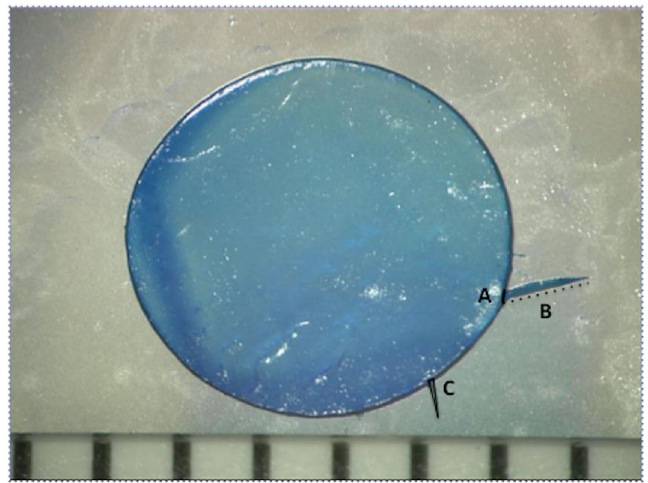
Figure 5. Description of an arc-length, tag-length and tag-area of a capsular tag. ( A ) The arc-length is the distance between the two edges of a capsular-tag, which are attached to the capsule (black line). ( B ) The tag- length is the distance between the edge of a capsular-tag attached to the capsule and the farthest unattached edge (dotted black line). ( C ) The tag-area is the total region of square units occupied by a tag (black